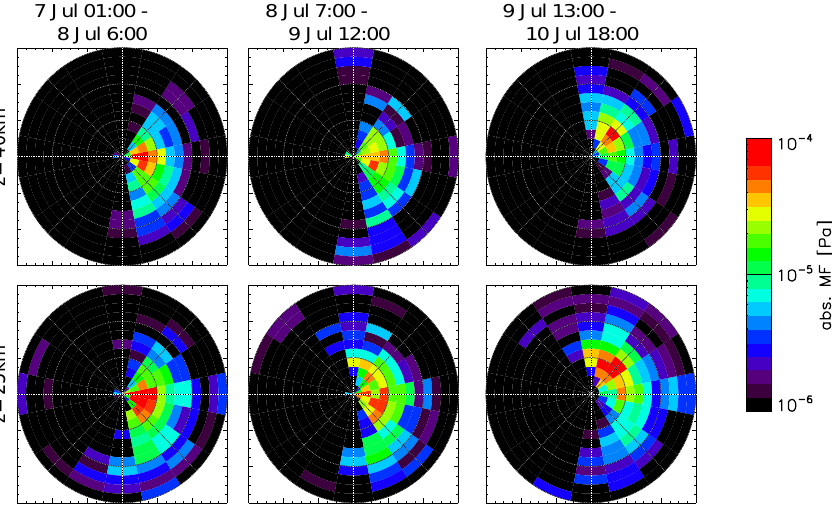
Fig. 5. Momentum flux spectra from the S3D analysis method applied to model winds. The radial coordinate is phase speed, origin is 0ms − 1 , circles give phase speeds of 20ms − 1 , 40ms − 1 and 60ms − 1 . The ground-based phase speed is determined from the vertical wavelength and background winds. Color scale is